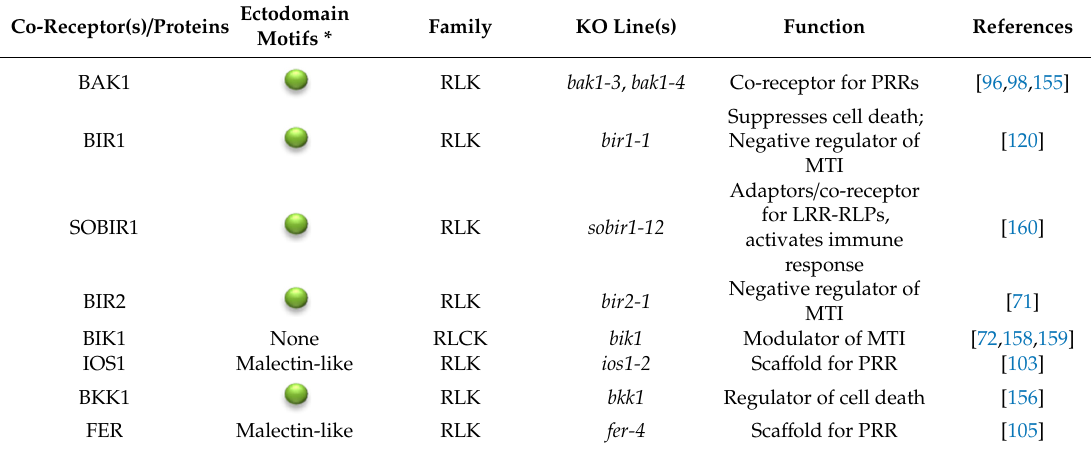
Table 1. Defence-related PRRs and associated protein KOs in A. thaliana . Table 2. Defence-related BAK1 and other associated protein KOs in A. thaliana .